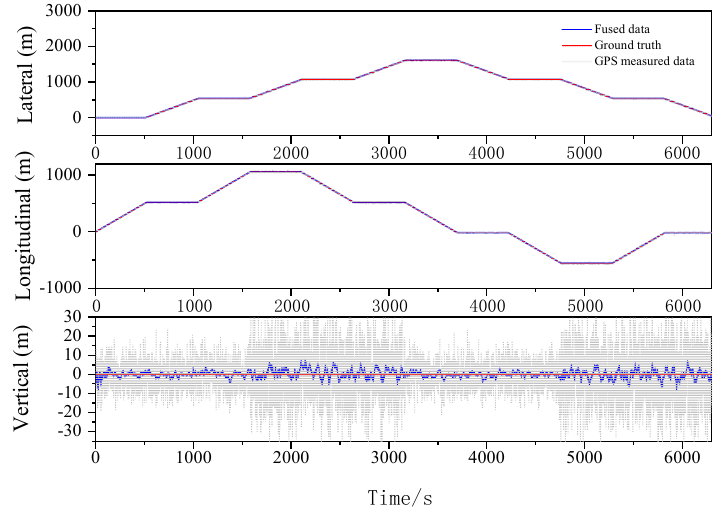
Figure 15. Lateral, Longitudinal and Vertical positions of ESKF (Polygonal).